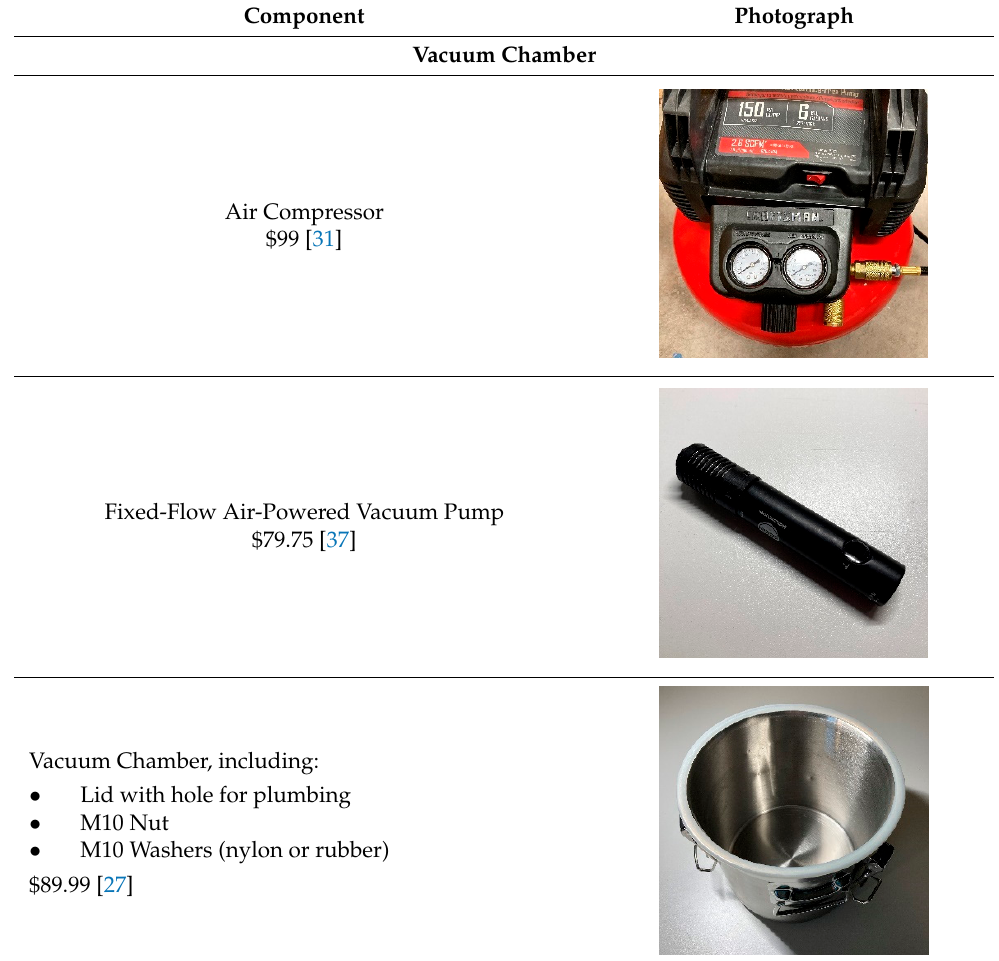
Table A1. Visual bill of materials separated between the two primary components.